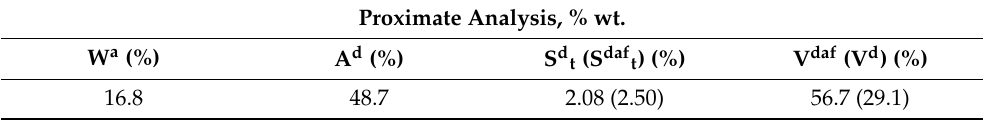
Table 1. Proximate analysis of lignite *.